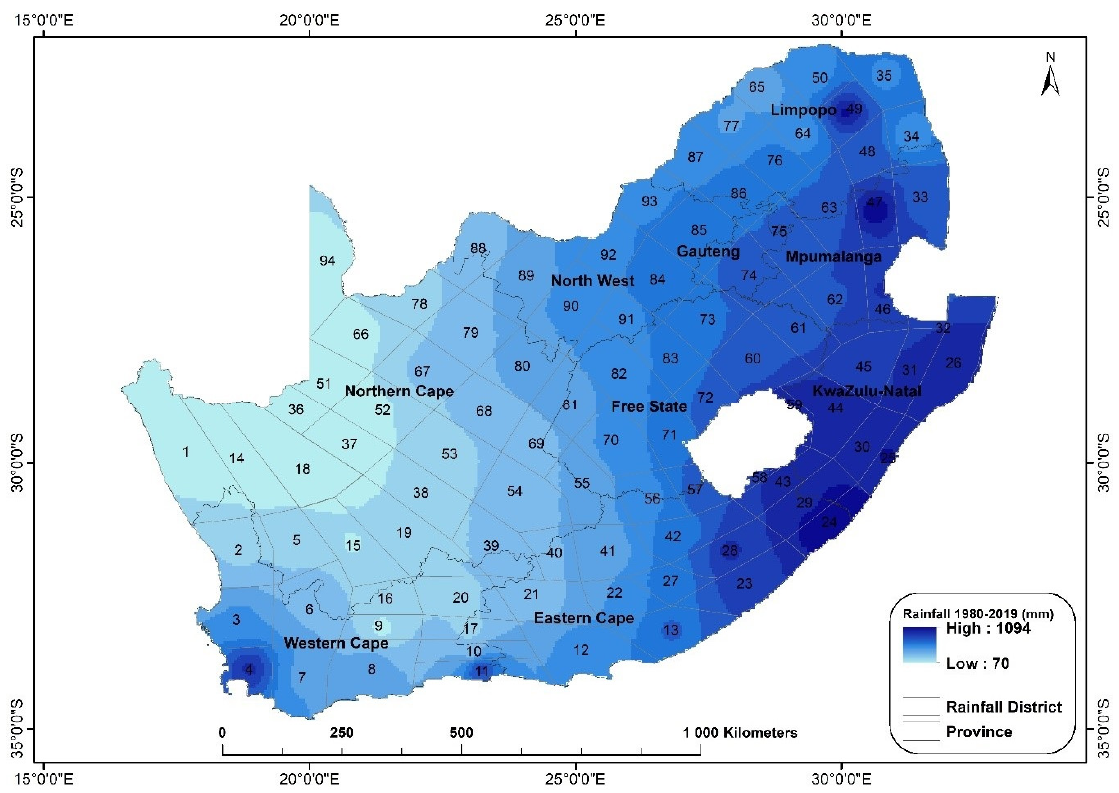
Figure 1. Map of rainfall districts for South Africa (SAWB, 1972) with provincial borders showing annual total rainfall 1980–2019.